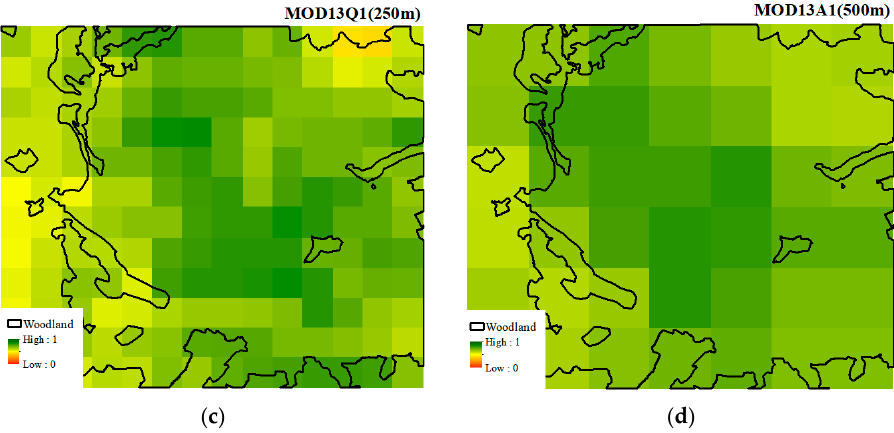
Figure 2. ( a – d ) Spatial distributions of FVCs extracted from a sample site of Sentinel-2 (10 m), Landsat-8 (30 m), MOD13Q1 (250 m), and MOD13A1 (500 m) image sources. The area surrounded by black lines is woodland.